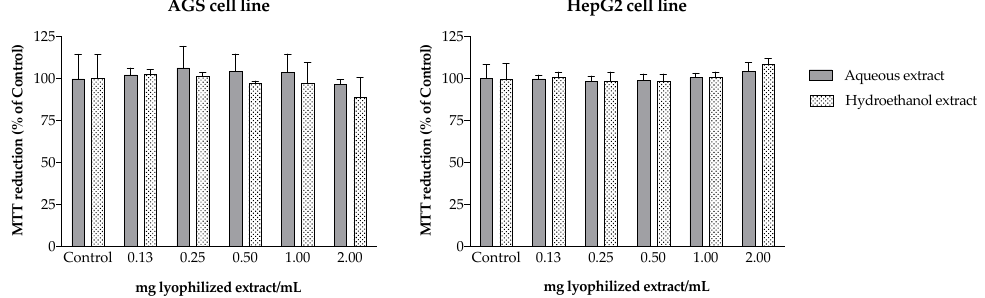
Figure 5. Effect of camel grass extracts on MTT reduction in AGS and HepG2 cells. Results are ex- pressed as percentage of untreated control (mean ± SD of four determinations performed in tripli- cate).